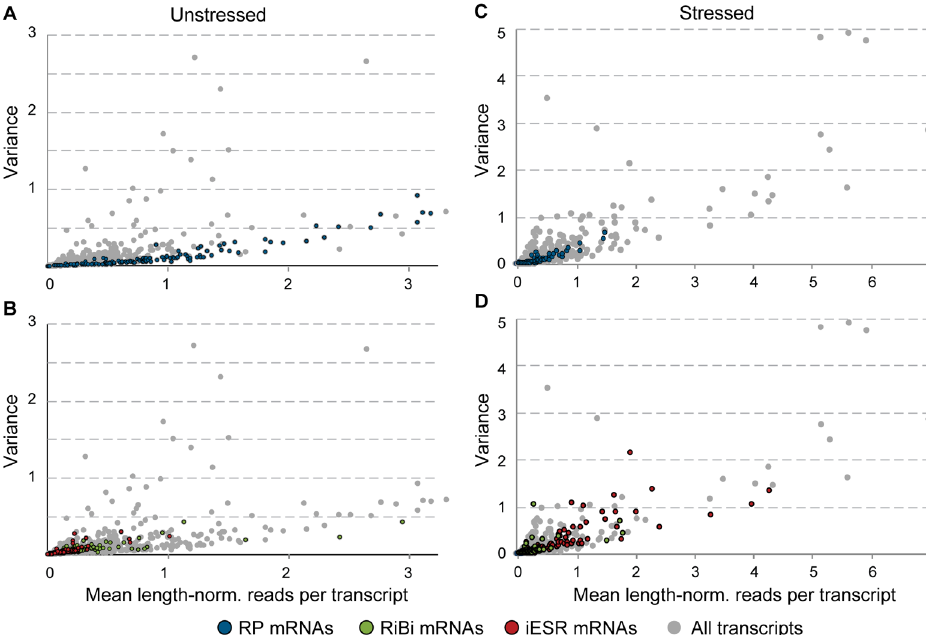
Fig 2. RP transcripts show low variation in abundance across cells. The mean and varianceof transcript read counts per mRNA length (“length-norm”) was plotted for each mRNA from unstressed(left) or stressed (right) cells. (A,C) highlightRP transcripts and (B,D) highlightiESR and RiBi transcript againstall other mRNAs (grey points). Plots are zoomed to capture most points. iESR, induced-EnvironmentalStress Response; RiBi, ribosomebiogenesis; RP, ribosomal